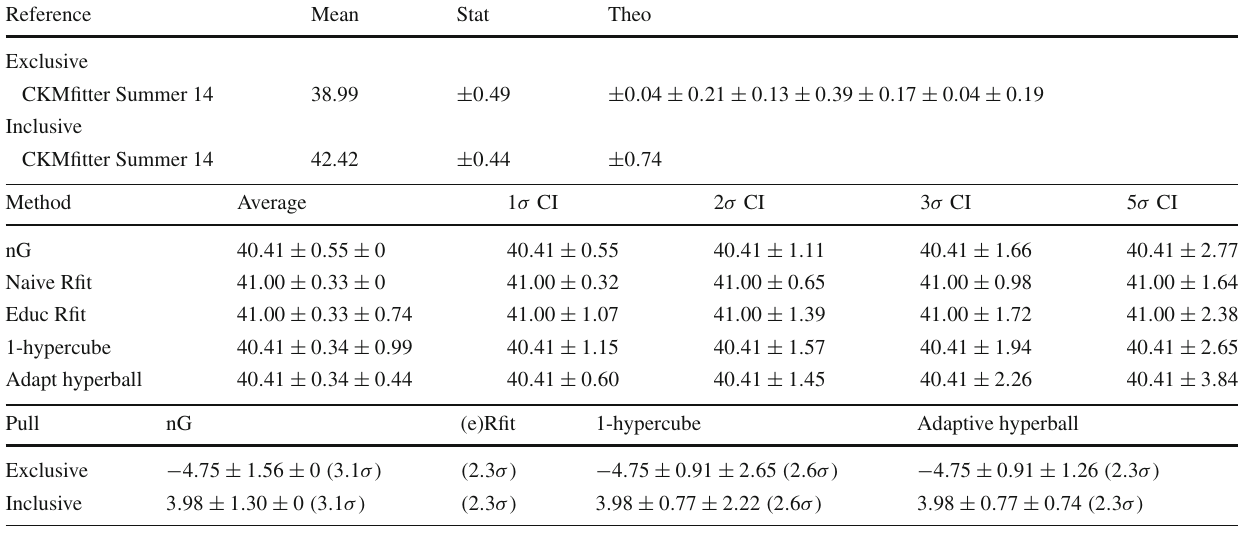
Table 10 Top: determinations of | V cb |· 10 3 from semileptonic decays. Middle: averages according to the various methods, and corresponding confidence intervals for various significances. Bottom: pulls associated to each determination for each method. For Rfit methods, we quote only